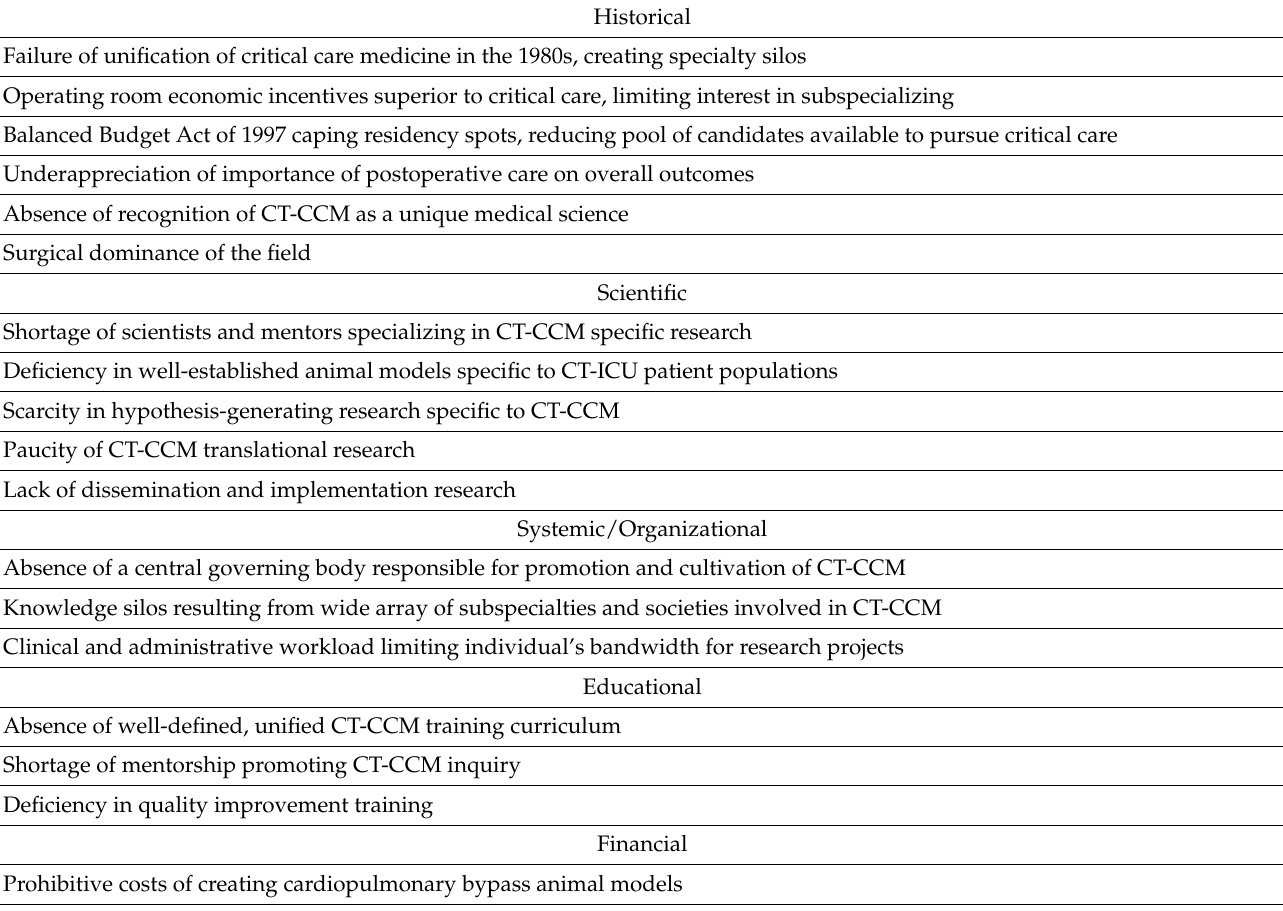
Table 1. Barriers to Knowledge Expansion in Cardiothoracic Surgical Critical Care